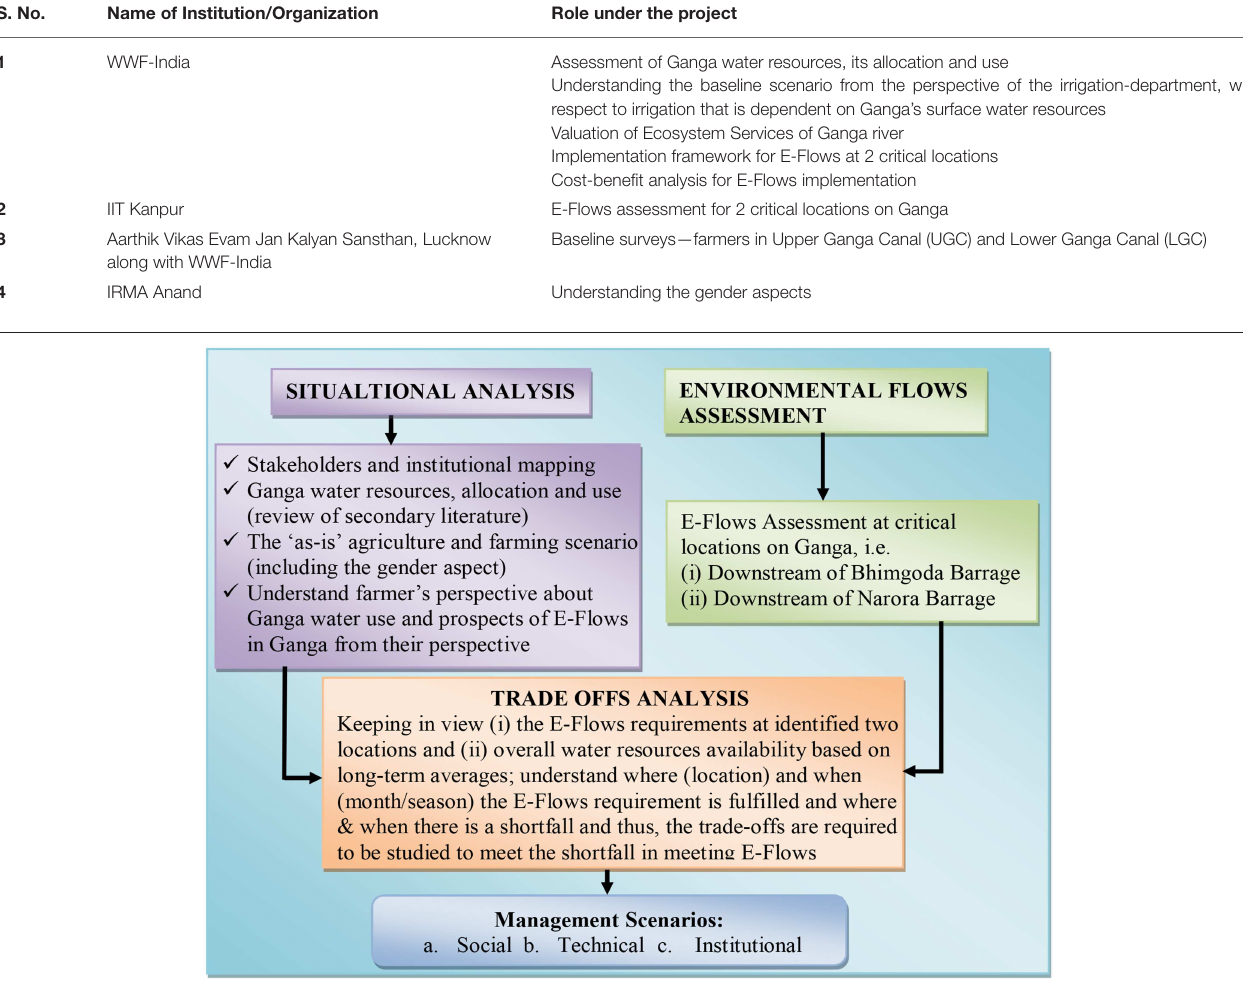
FIGURE 1 | Process chart exhibiting the methodology for the